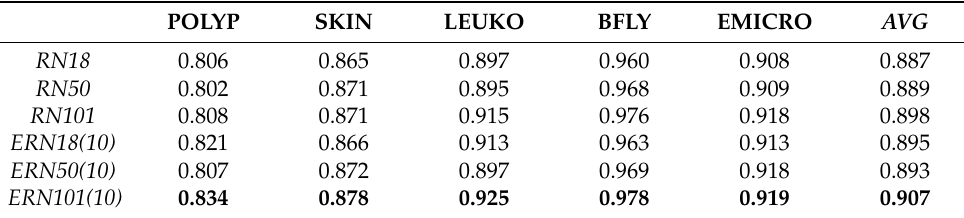
Table 2. Performance (dice) of the proposed ensembles in the five benchmark datasets; the last column AVG reports the average performance. Best performance is marked in bold